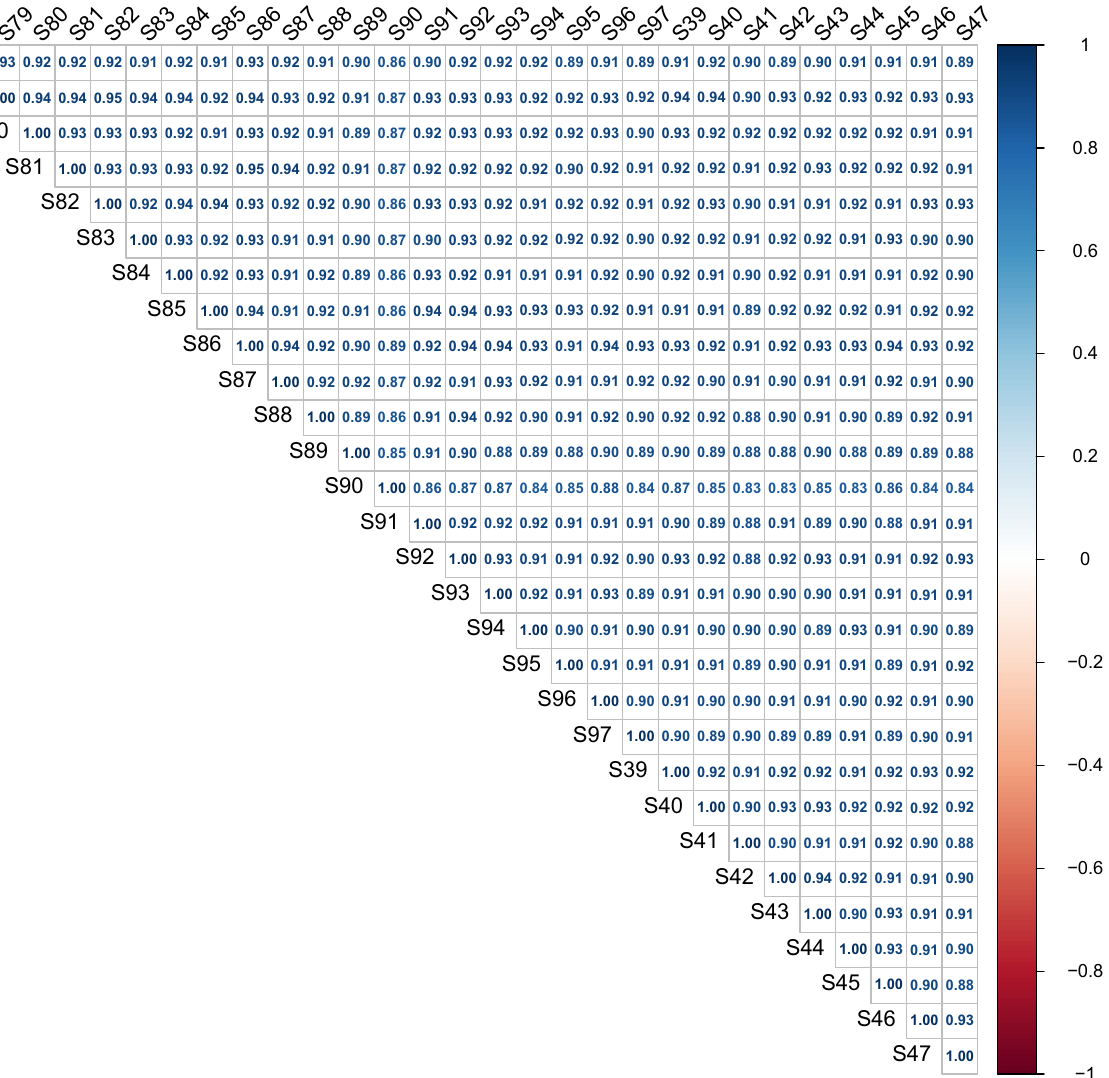
Figure 1. The heat map presents the results of a quantitative correlation analysis between proteins across multiple samples. The color intensity of each cell in the picture represents the intensity and direction of the correlation between protein levels in a given sample. Blue is a positive correlation and red is a negative correlation. The darker the color is, the stronger the correlation is. The software used to create the map is R 4.1.0 (https:// www.r- proje ct.